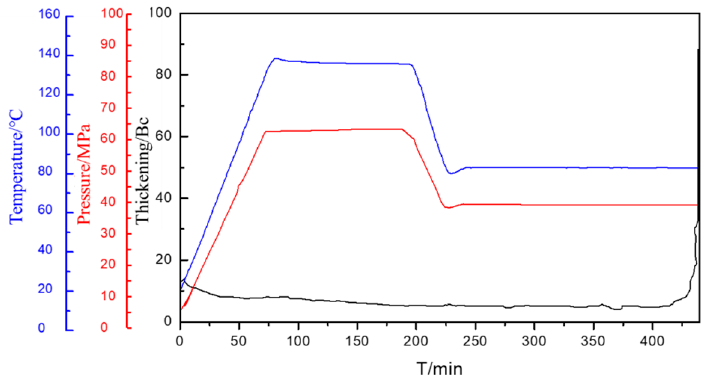
Figure 9. Thickening curve of polymeric ion retarder from 150 °C to 90 °C.